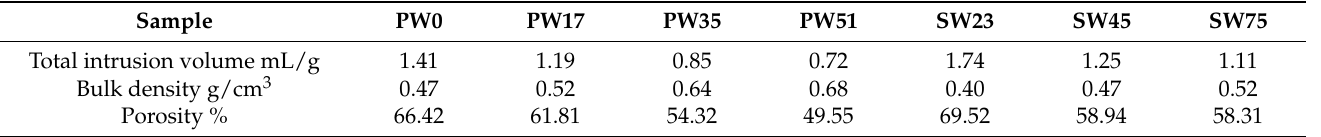
Table 2. Bulk density and porosity of control wood and furfurylated poplar and Chinese fir